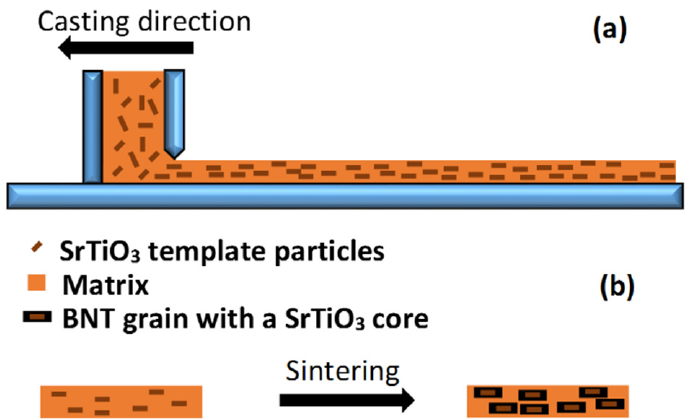
Figure 9. Schematics of template alignment by tape casting ( a ) and the texture fraction increases with heating ( b ) (based on reference [117]).